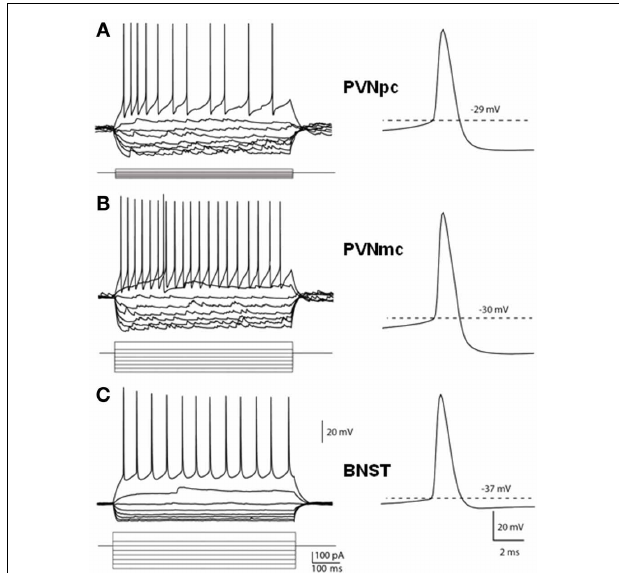
FIGURE 4 | Distinct membrane properties of putative CRF neurons in the PVN and type III CRF neurons in the BNST ALG . Representative traces demonstrate the membrane responses of these neurons to membrane current injections and typical spikes. (A) PVNpc neurons have extremely high input resistance and high threshold for spike firing. When hyperpolarized, these neurons exhibited an inward rectification current. No outward rectification was observed during depolarization current injections. Right trace shows a typical spike that has high firing threshold and a prominent fAHP. (B) PVNmc neurons have smaller input resistance than that of PNVpc neurons and also have high threshold for spike firing. Single spike trace also shows this neuron has a high spike threshold and prominent fAHP. (C) In comparison to the PVN CRF neurons, CRF neurons in the BNST have lower input resistances, lower spike threshold and smaller fAHP. PVNmc, PVNpc represent magnocellular and parvocellular neurons of PVN respectively.